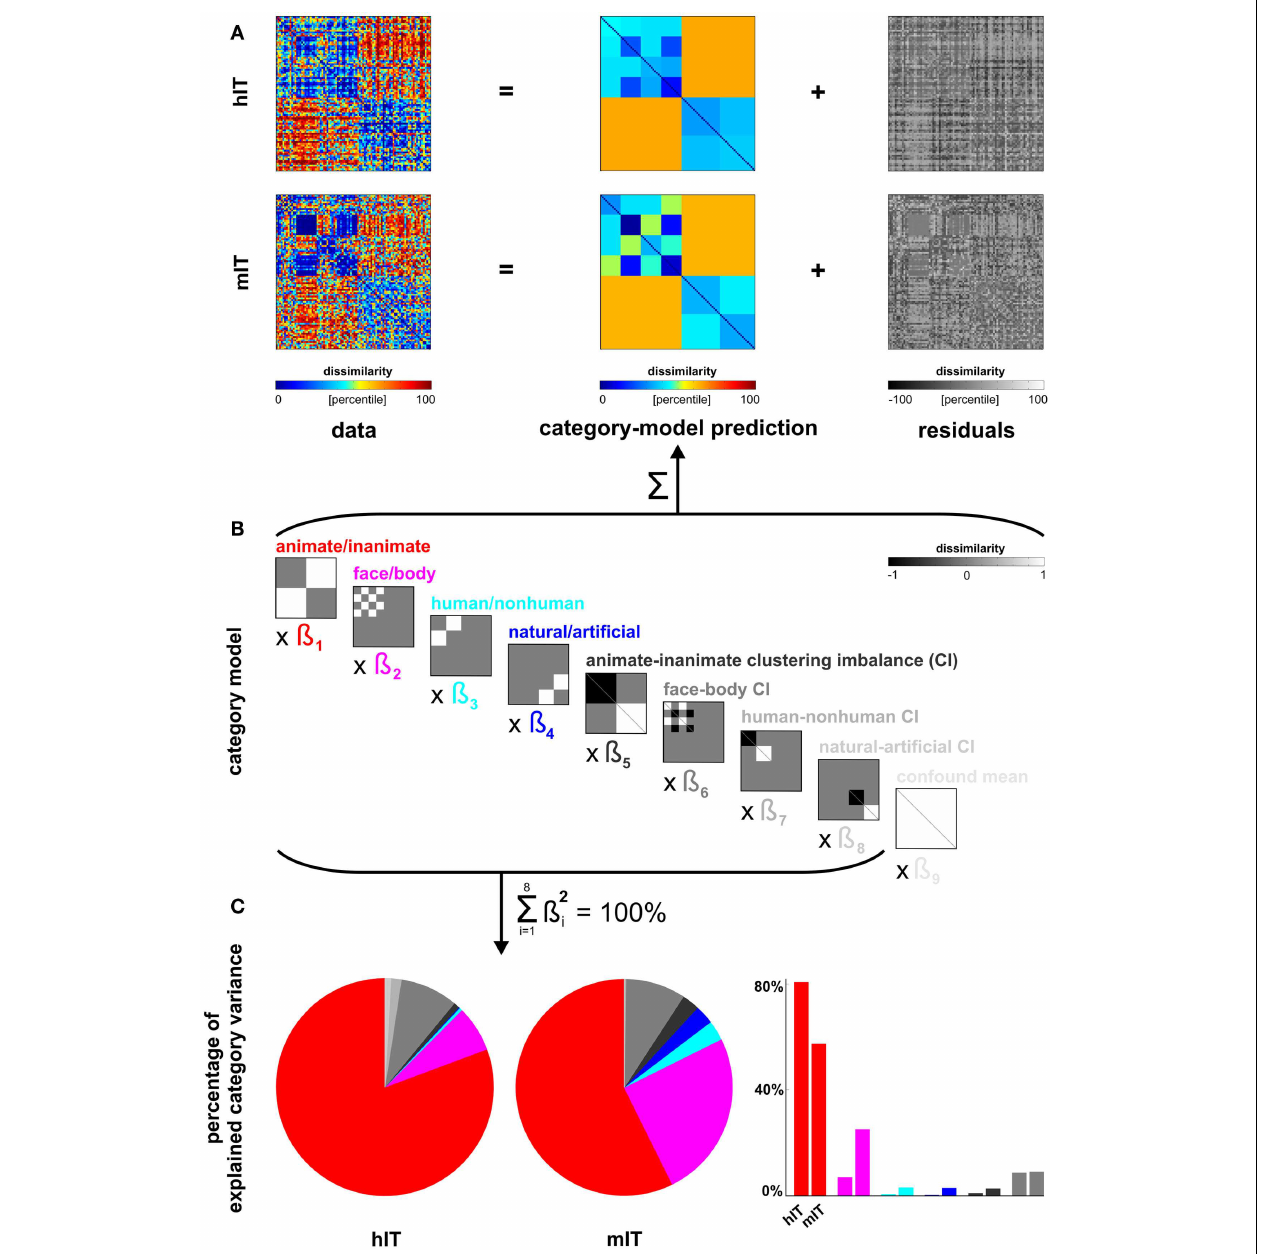
FIGURE 6 | Categorical divisions in human IT and monkey IT. We used the linear model from Figure 5 (repeated in (B) for convenience) also to compare the IT representations between human and monkey [same data as in Kriegeskorte et al. (2008b) for both species; a more in-depth analysis of the monkey data is Kiani et al. (2007)]. (A , B) The proportion of residual variance was greater in mIT than hIT. Residual variance was therefore equated by adding noise to the hIT matrix (which is therefore not identical to Figure 5 ). human judgments, see Figure 7